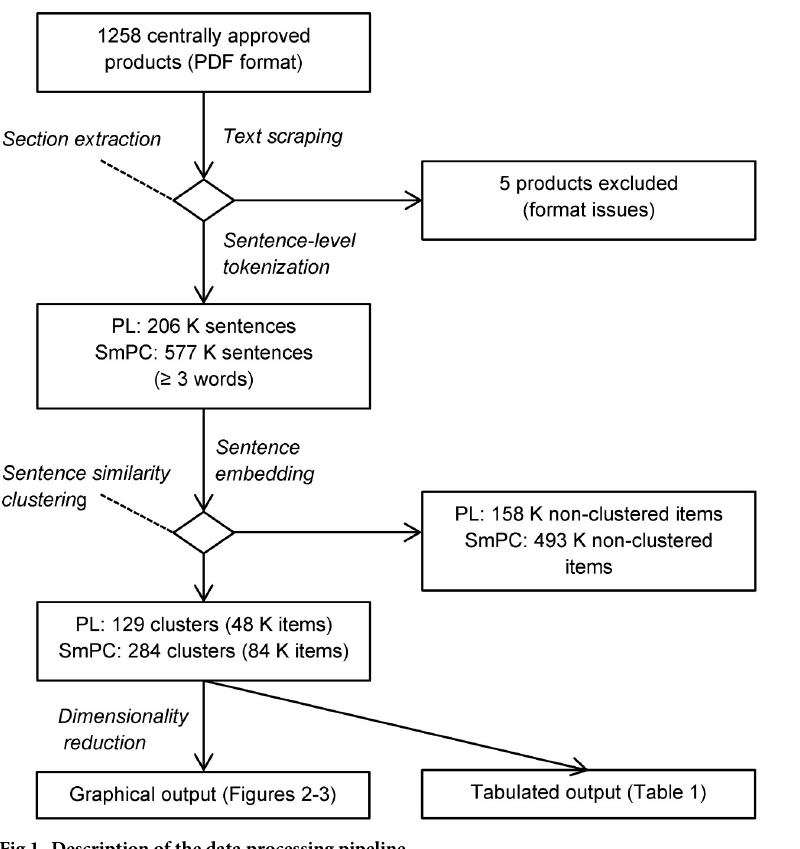
Fig 1. Description of the data processing